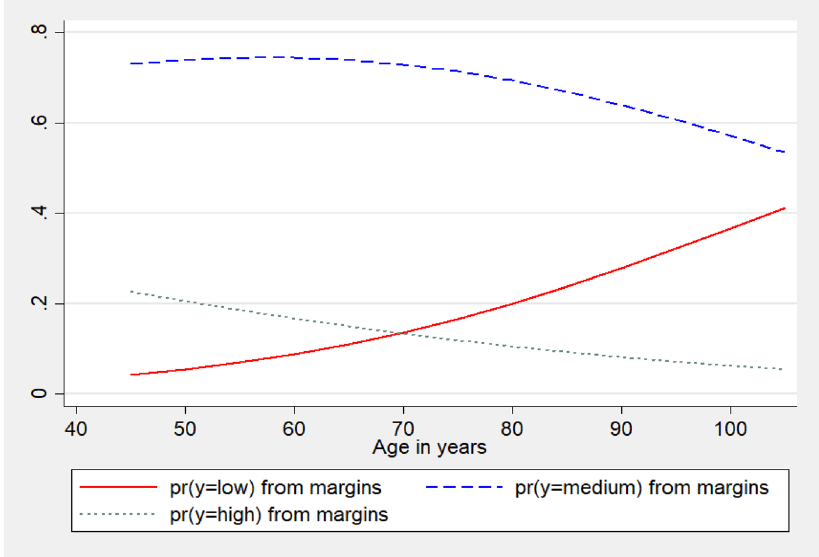
Figure 1. Average marginal effects of age on low, medium and high cognition among older adults, LASI, Wave 1,